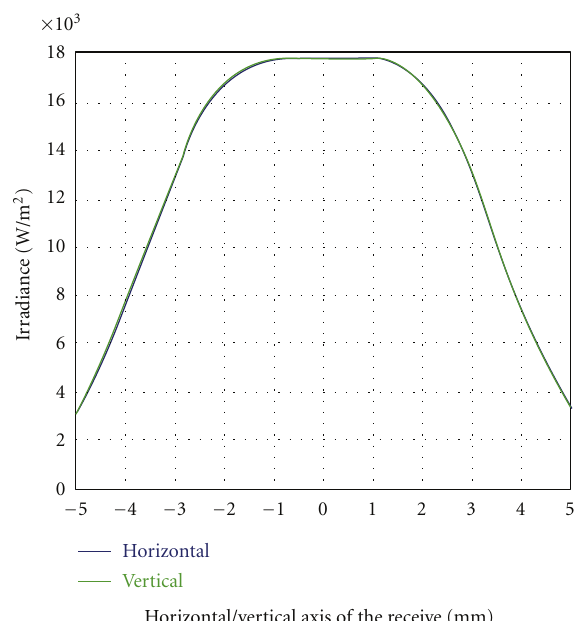
Figure 5: Illumination distribution curve on the receiver surface.